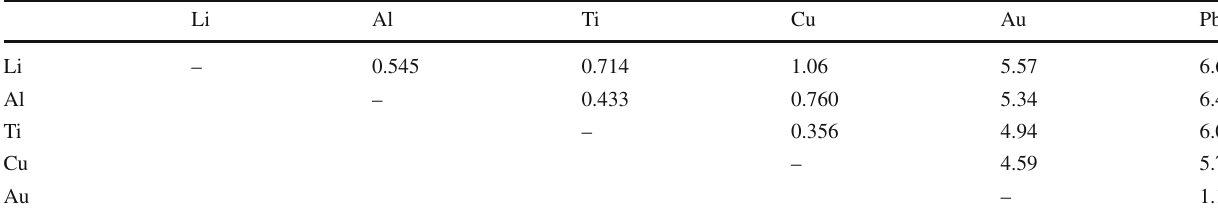
Table 3 Misalignment angles (in degrees), between target vectors expressed in the quark operator